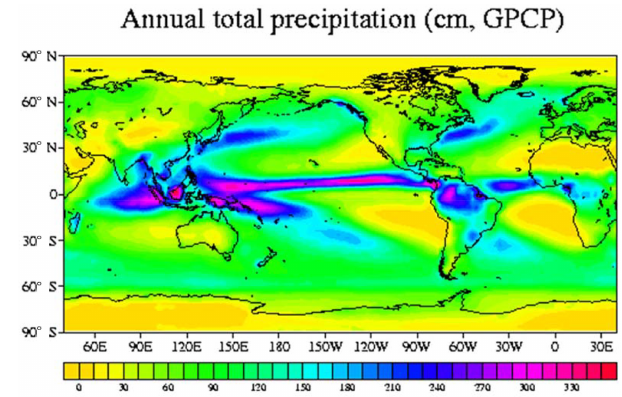
Figure 10. Average rainfall measured by several satellites, sounders and rain gauges combined for the years 1988 to 2004. Source: GPCP (2018).